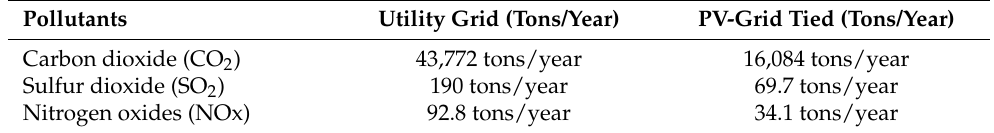
Table 14. Pollutants’ Environmental